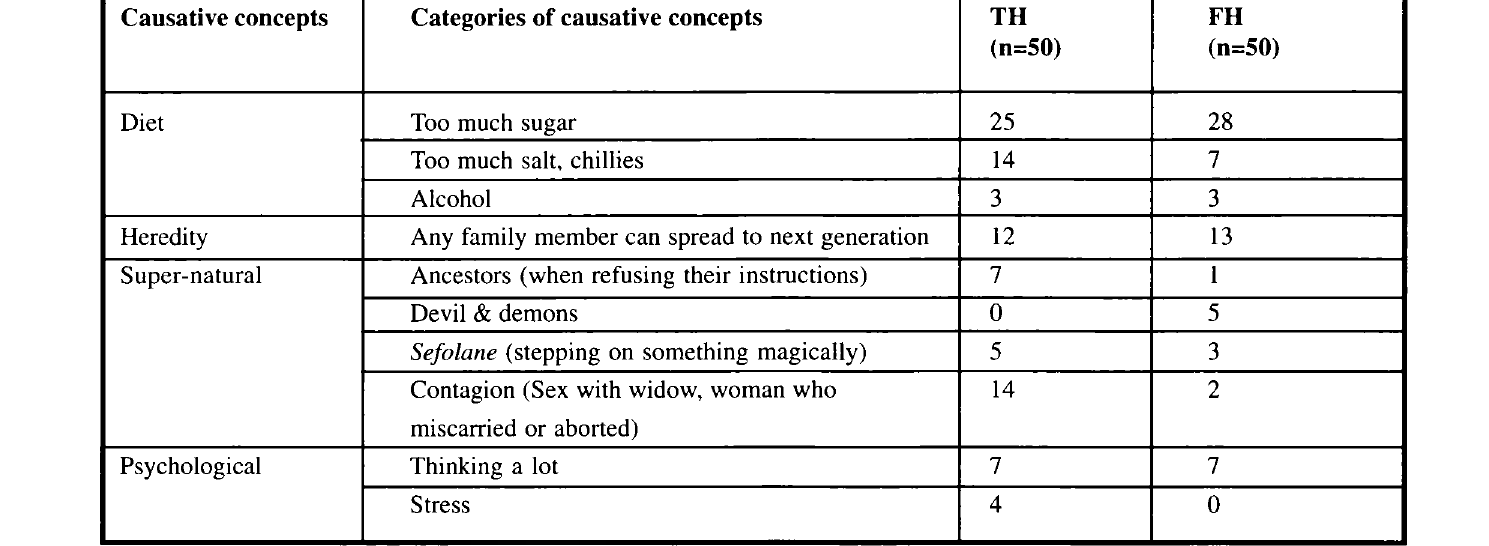
Table 2: Perceived causes of diabetes by traditional healer (TH) and faith healer (FH) by frequency Causative